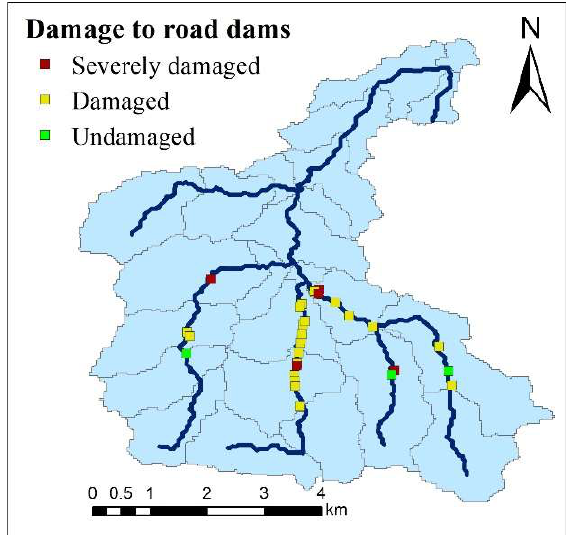
Figure 11. Distribution of damage to the upstream road dams in Wangzongdian Village.